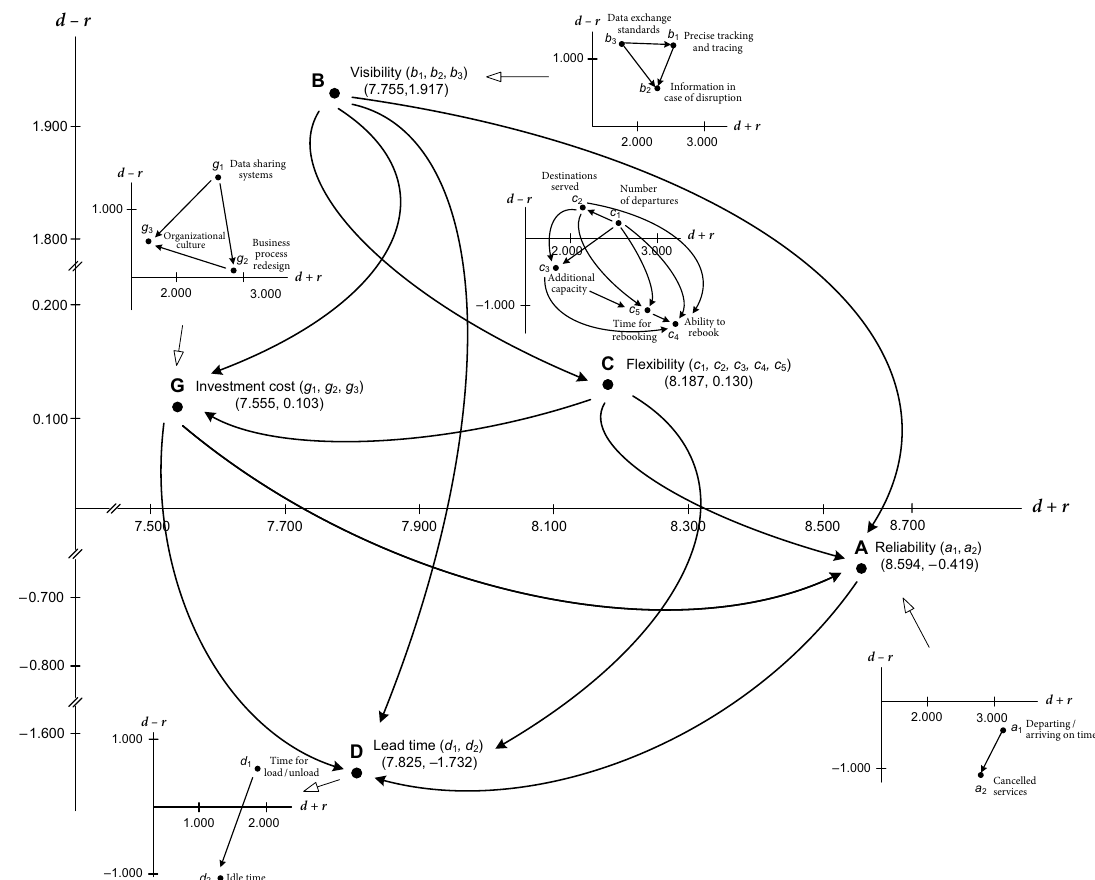
Figure 6. Causal diagram of total relationships: shippers’ perspective